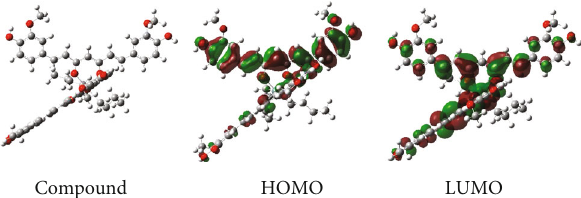
Figure 10: Optimized molecular structure and HOMO and LUMO orbitals of the Sn-metallic complex, SnX molecule. Atomic colours represent gray (C), white (H), red (O), blue (N), and dark-blue- square